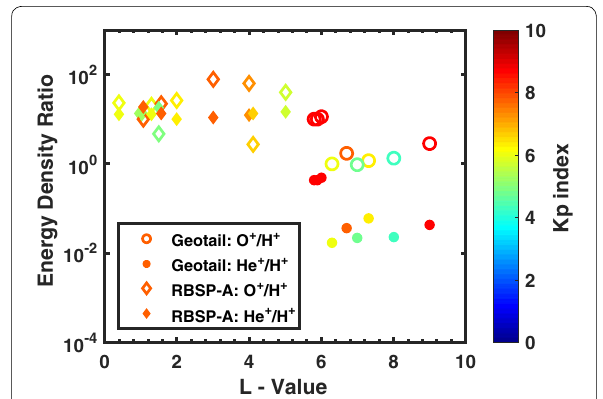
Fig. 8 L value dependence of energy density ratio with respect to Kp